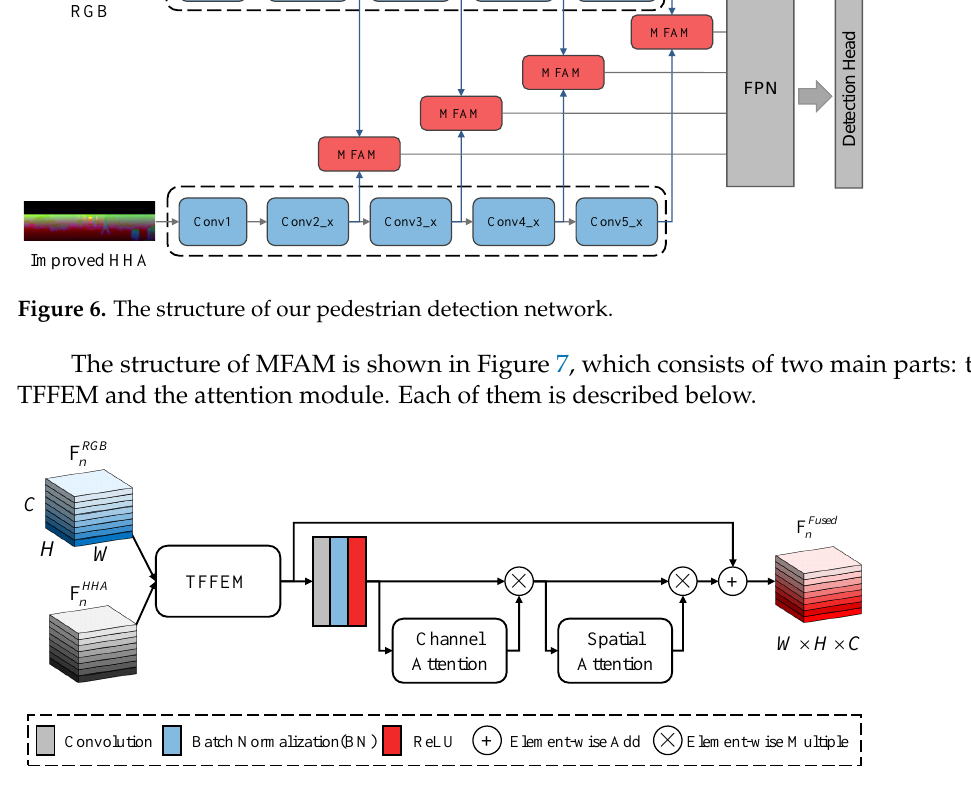
Figure 7. The structure of our proposed